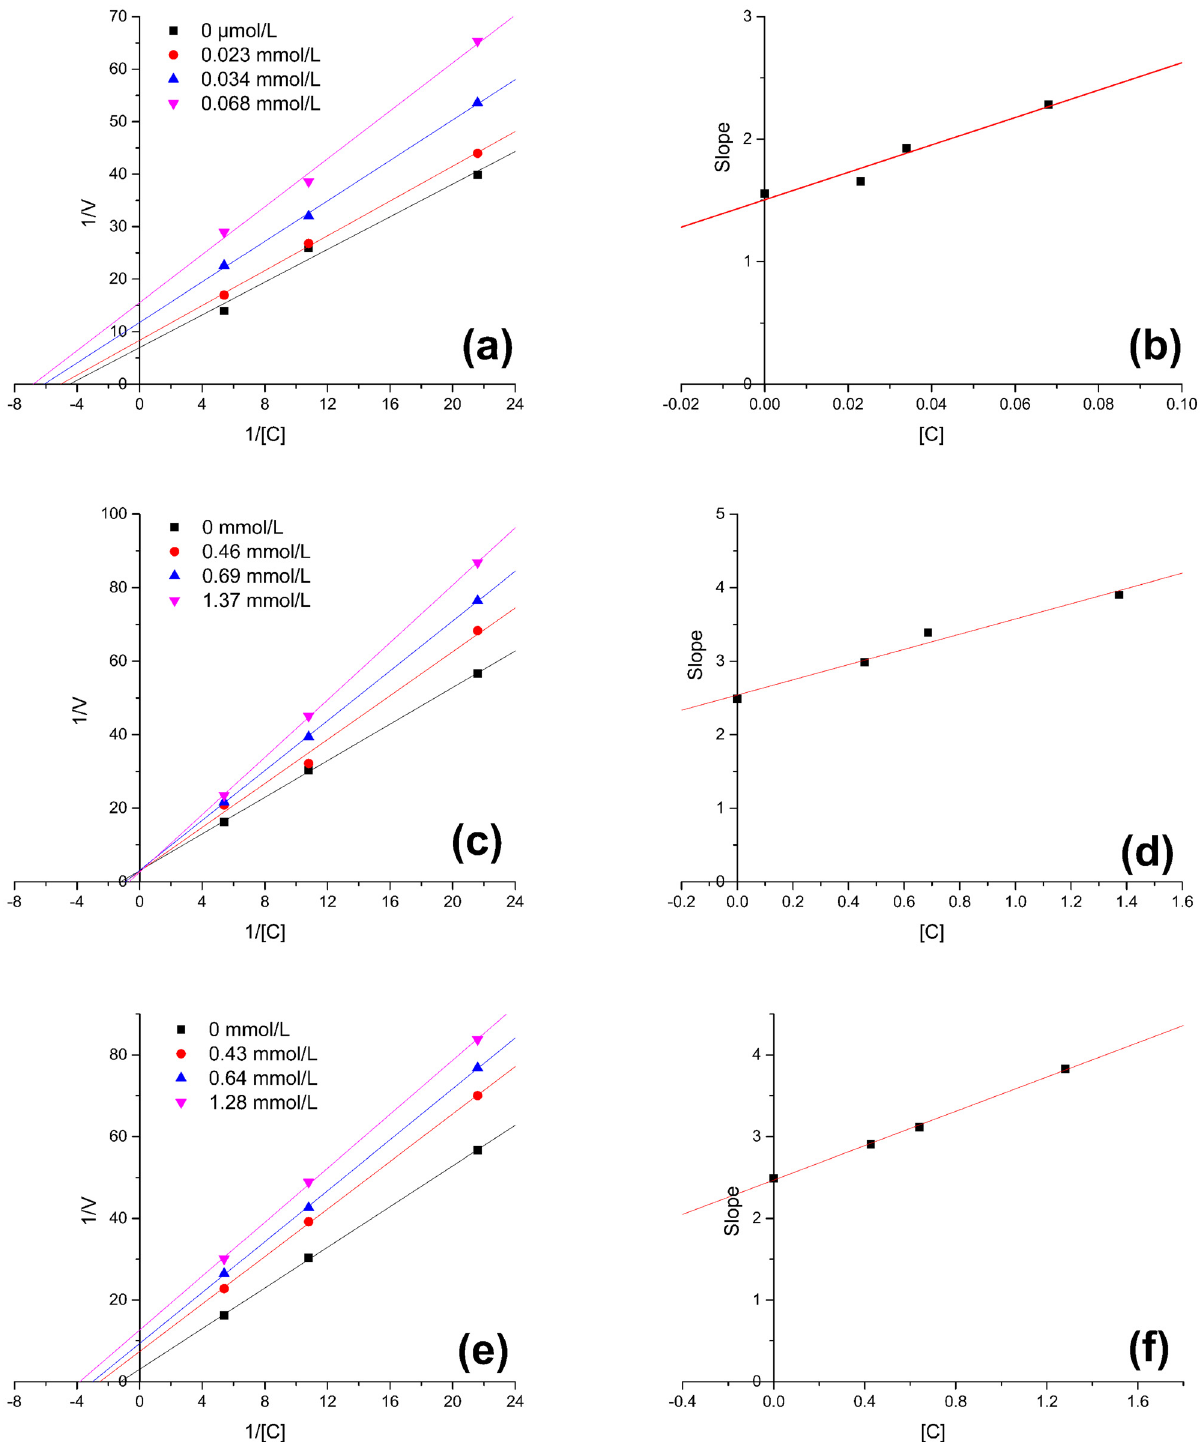
Figure 5: Lineweaver – Burk plots for inhibition of xanthine oxidase by ( a ) chlorogenic acid, ( c ) echinacoside, and ( e ) isorhamnetin - ruti - noside. Secondary plots of slopes against concentrations of ( b ) chlorogenic acid, ( d ) echinacoside, and ( f ) isorhamnetin - rutinoside to calculate K i